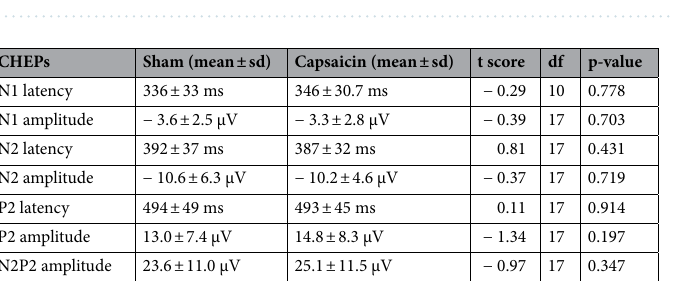
Figure 4. Measure of Mechanical and Thermal Hyperalgesia. Comparison of the sham and capsaicin condition for (row a ) mechanical and (row b ) thermal pain rating for the CHEPs (white background) and LEPs session (grey background) separately. The condition (sham and capsaicin) is illustrated on the x-axis. In (row a ) the y-axis illustrates the difference in overall pain rating, which is calculated by subtracting the pre-cream from the post-cream pain. In (row b ) the y-axis illustrates average pain rating during the sessions. Subjects’ responses of both conditions are connected by a grey line.